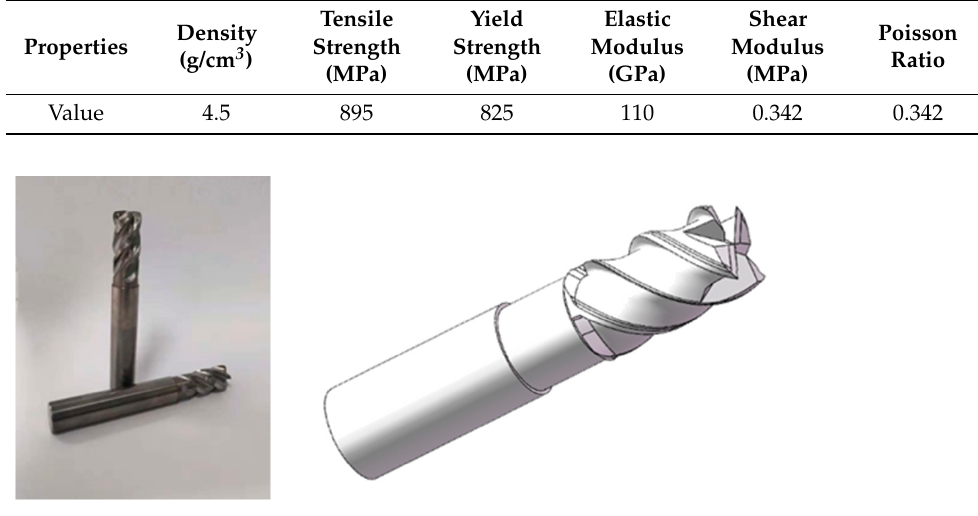
Figure 7. Helical milling tool and its 3D model. Table 3. The geometric and property parameters of cutting tool used in the experiment.